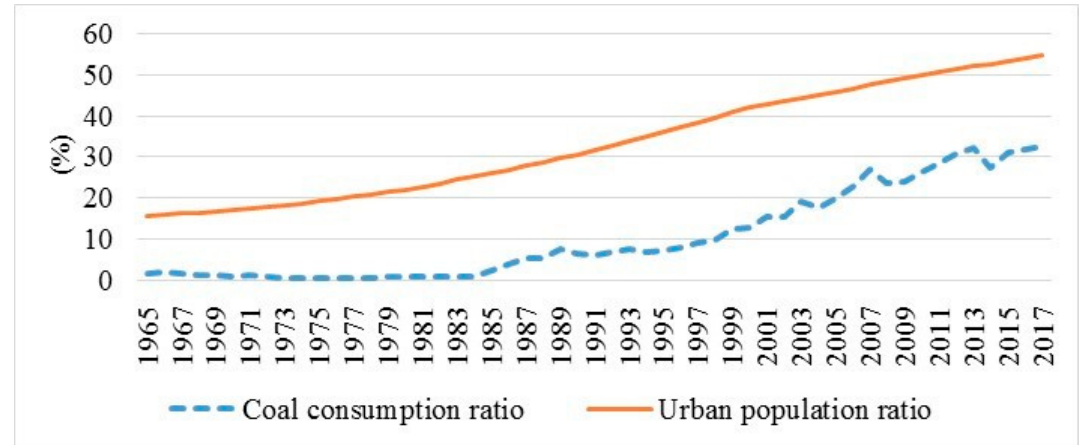
Figure 5. Ratios of coal consumption (relative to total energy consumption) and urban population (relative to total population).